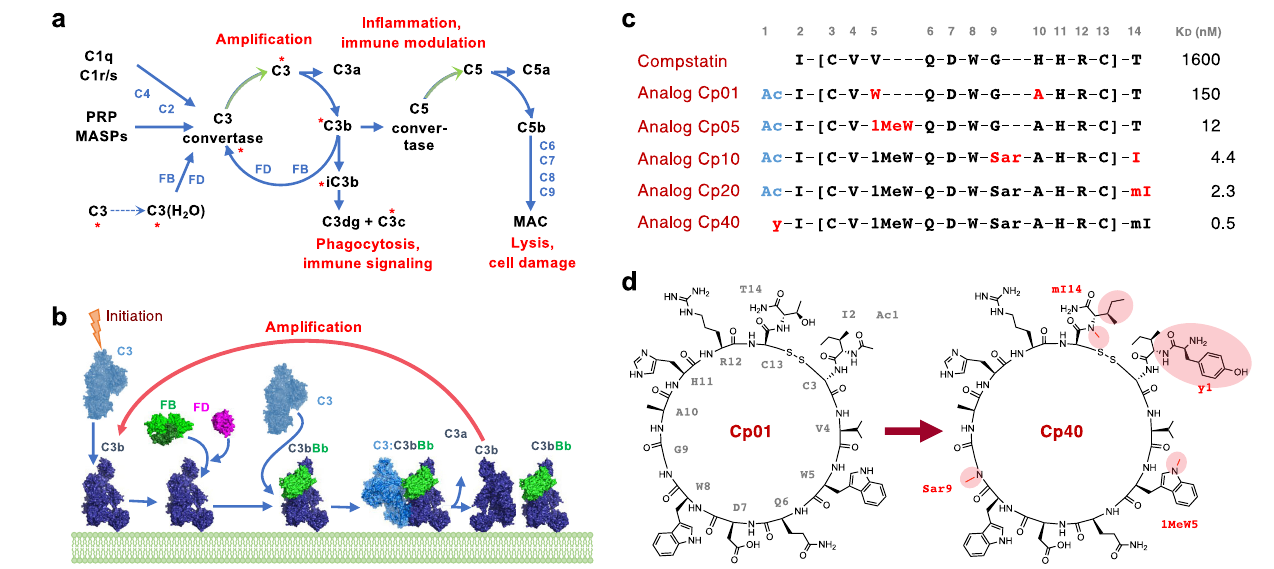
Fig. 1 | Overview of complement mechanisms and compstatin-based inhibitor development.a Simpli fi edschemeofthecomplementcascadewithmajoreffector functions.Moleculartargetsofcompstatinaremarkedwithanasterisk. b Structural modelofthe ampli fi cation loop basedonthe crystal structures of C3 (2A73) 22 , C3b (2I07) 18 , FB (2OK5) 50 , FD (2XW9) 5 , C3b 2 Bb 2 SCIN 2 (2WIN) 6 , and C3a (4HW5) 51 . c Amino acid sequences and target af fi nities of compstatin and major analogs relevantforthisstudy.Residuenumbersareindicatedatthetop,andchangesfrom the previous analog are highlighted in red. Binding af fi nities (K D ) to C3/C3b